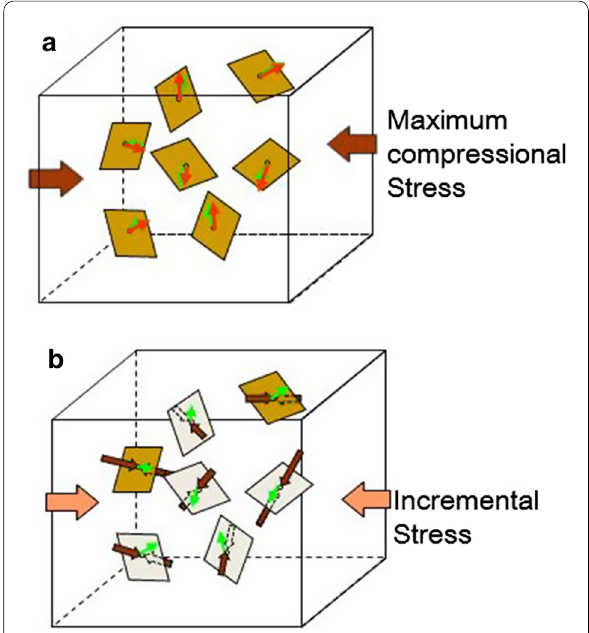
Fig. 1 Two different explanations of focal mechanisms. a A case of ordinary stress inversions (e.g., Gephart and Forsyth 1984; Michael 1984, 1987). Stress is assumed to be uniform in the analysis area. Small rectangles indicate faults. Green and red arrows indicate observed slip directions from focal mechanisms and calculated slip directions inferred from the direction of maximum shear on the fault, respectively. Brown arrows indicate axes of the maximum compres- sional stress. b Hypothesis of Smith and Heaton (2011). Each fault plane is subjected to different maximum compressional stress, as indicated by brown arrows. Earthquake slips occur only on the faults indicated by colored rectangles, on which the stress has a similar orientation to the incremental